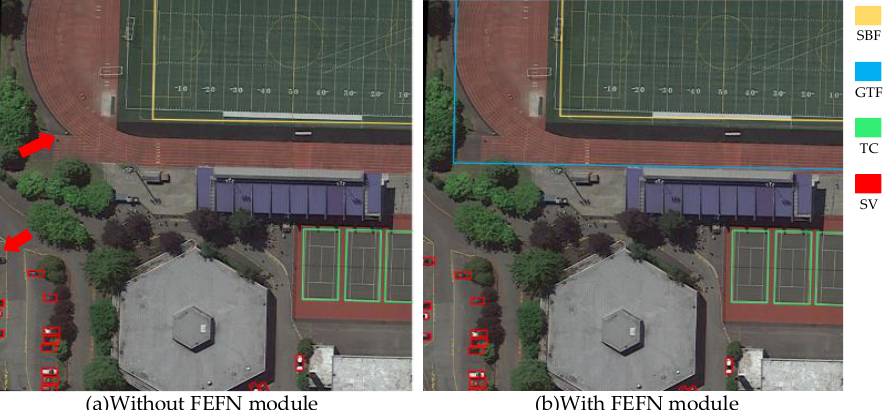
Figure 6. Visualization comparison results without/with FEFN.